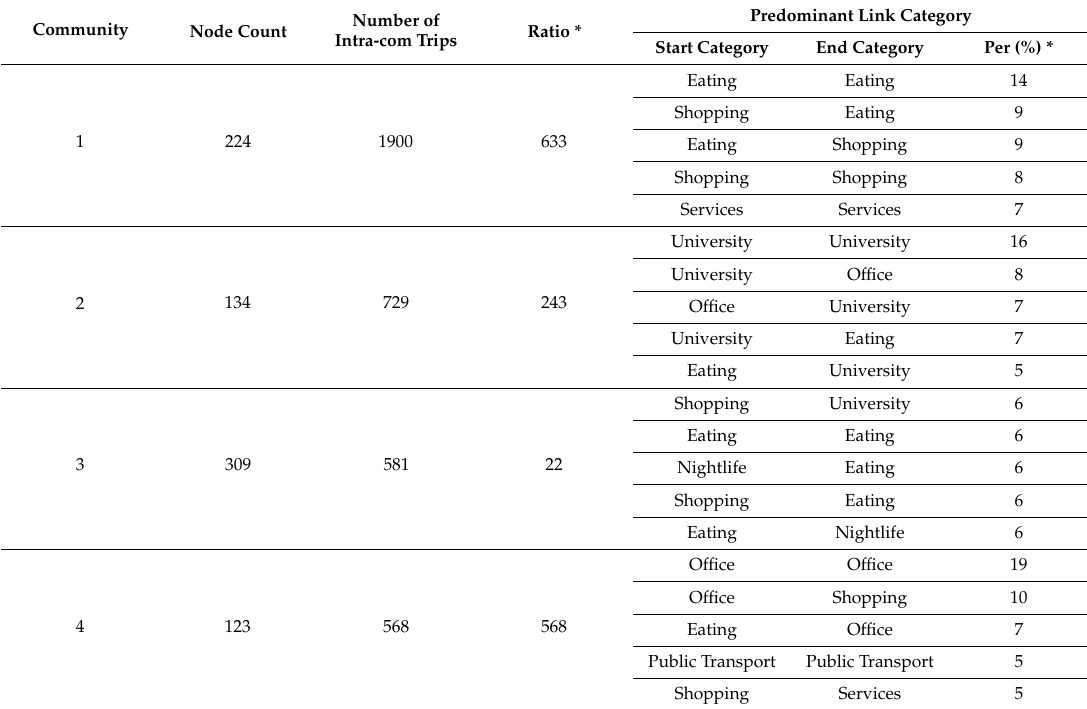
Table 3. Names and percentages of the most predominant land use categories within convex hulls of typical communities selected.